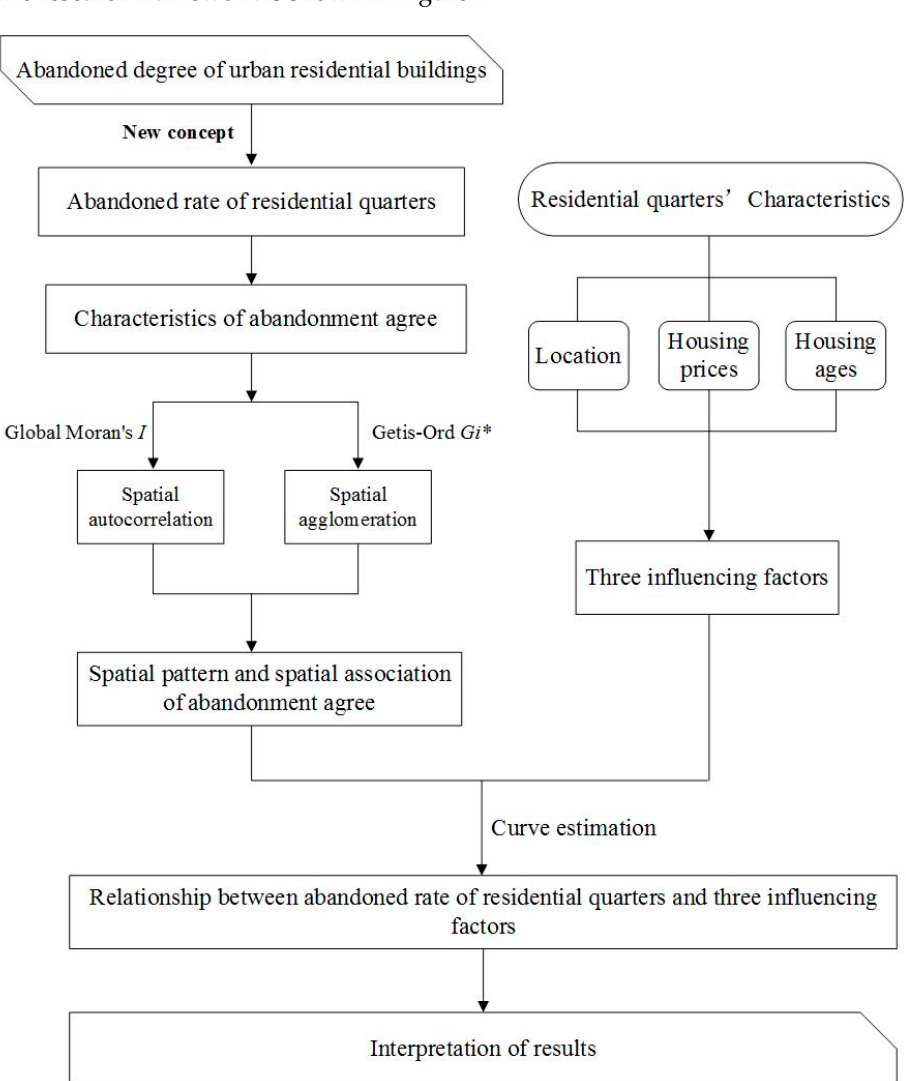
Figure 1. Research